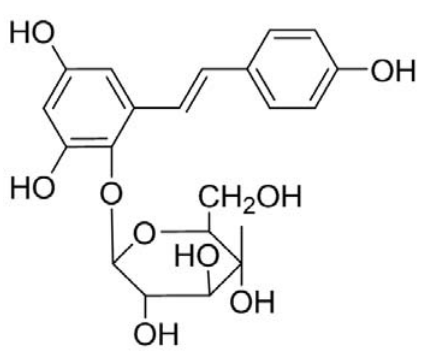
Figure 1. Chemical structure of